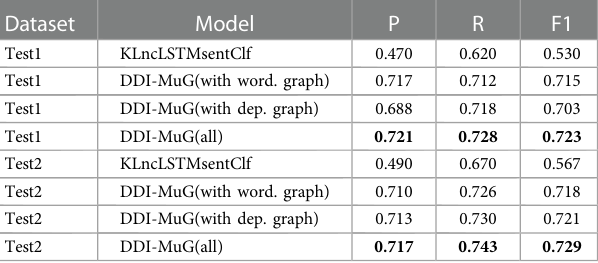
TABLE 6 Comparison with baseline models on the TAC 2018 corpus. The highest value is labelled in bold.